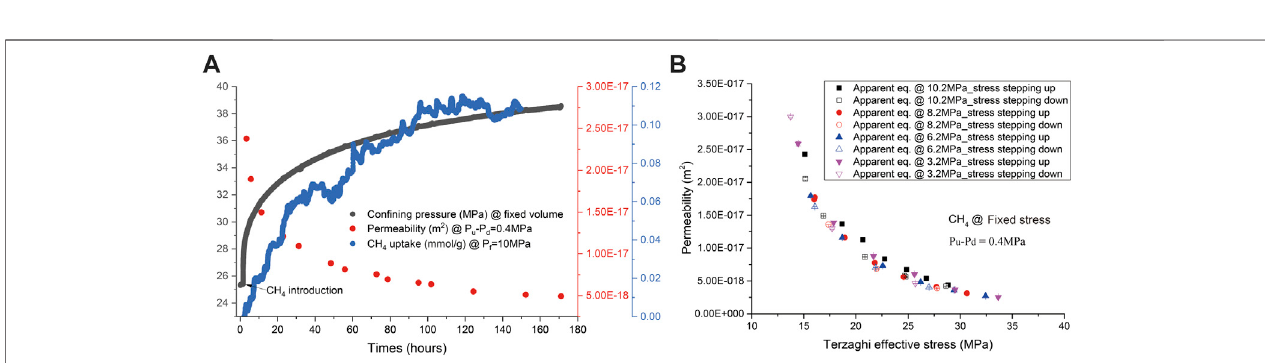
FIGURE4| DevelopmentofCH 4 permeability,thecon fi ningpressure,andCH 4 uptakeagainsttimeobtainedunderthe fi xedvolumeboundarycondition,illustrated in (A,B) showing development of CH 4 permeability as a function of Terzaghi effective stress performed under the fi xed stress boundary condition.